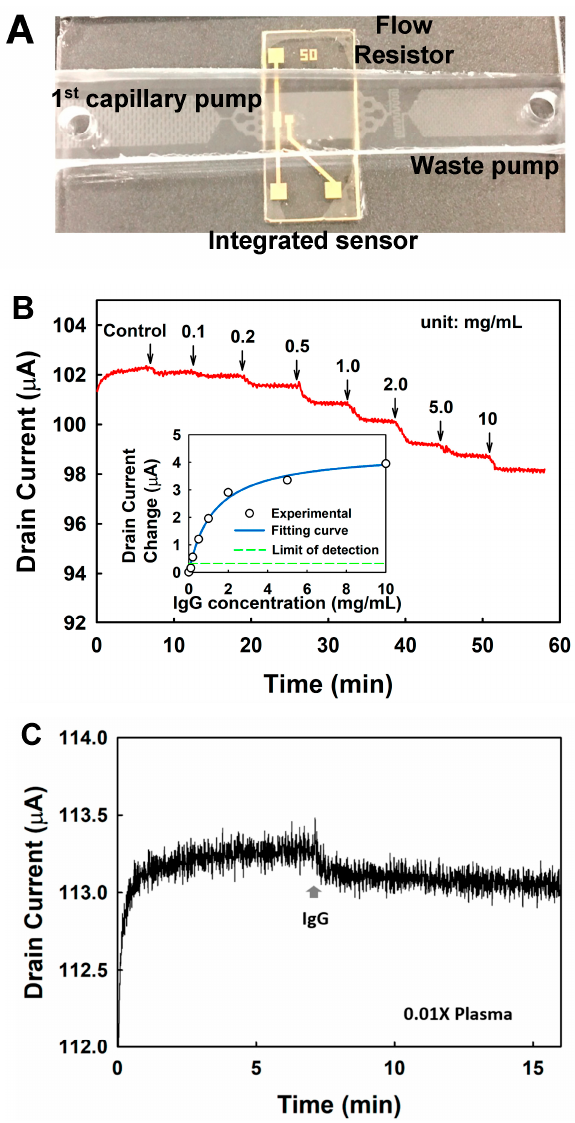
Figure 7. Real-time detection of IgG using nanoelectronic sensor integrated with the LFD. ( A ) A representative picture shows a fabricated LFD integrated with a nanoelectronic biosensor; ( B ) Continuous measurement of the drain current as responding to the additions of IgG with increasing concentrations; ( C ) The detection of IgG directly from human plasma.